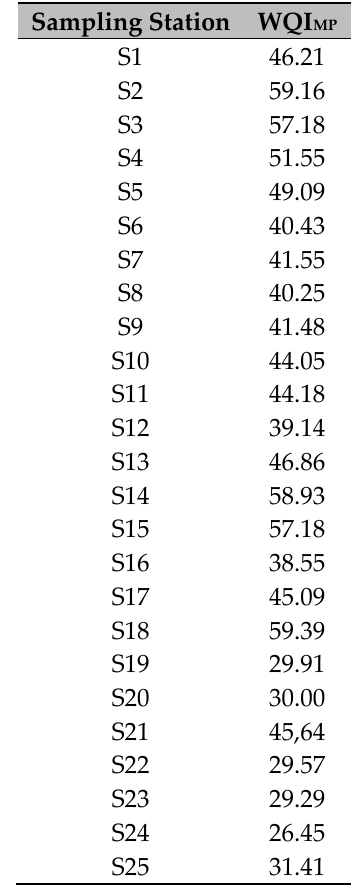
Table 2. Water Quality Index values during 2017.